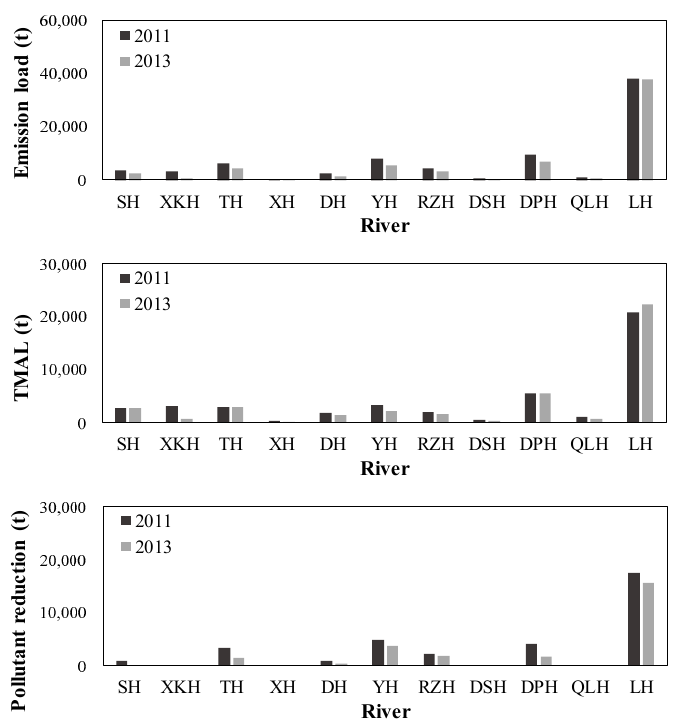
Figure 10. Comparisons of emission load, TMAL, and pollutant reduction of 11 rivers in QHD sea between 2011 and 2013.